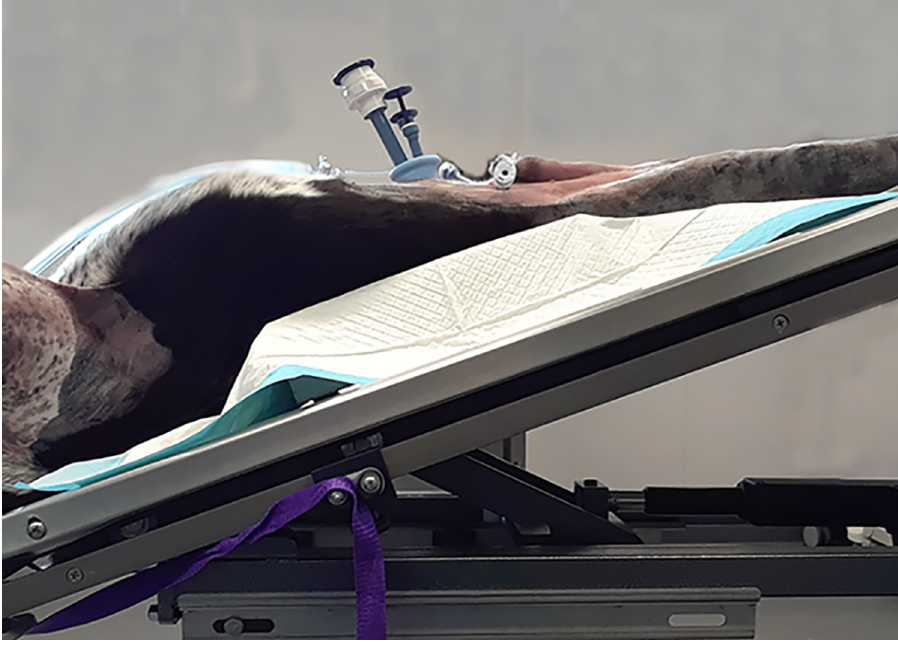
Fig 1. Canine cadaver in a severe Trendelenburg position for laparoscopic radical